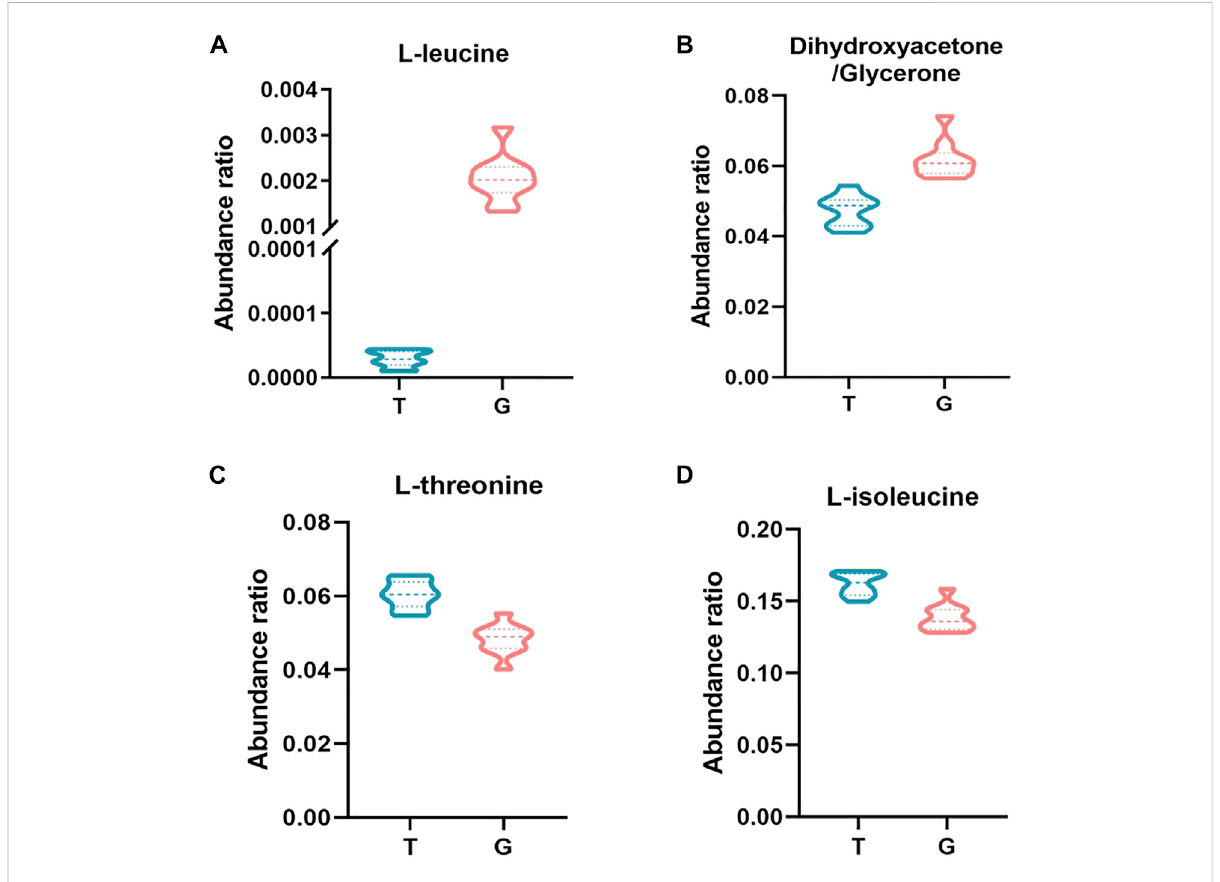
FIGURE 5 Abundance ratio of important metabolites in the freezing media of the T and G groups. (A) Dihydroxyacetone/glycerone. (B) Leucine. (C) Isoleucine. (D) Threonine. The difference was signi fi cant at the 0.01 level between the T and G